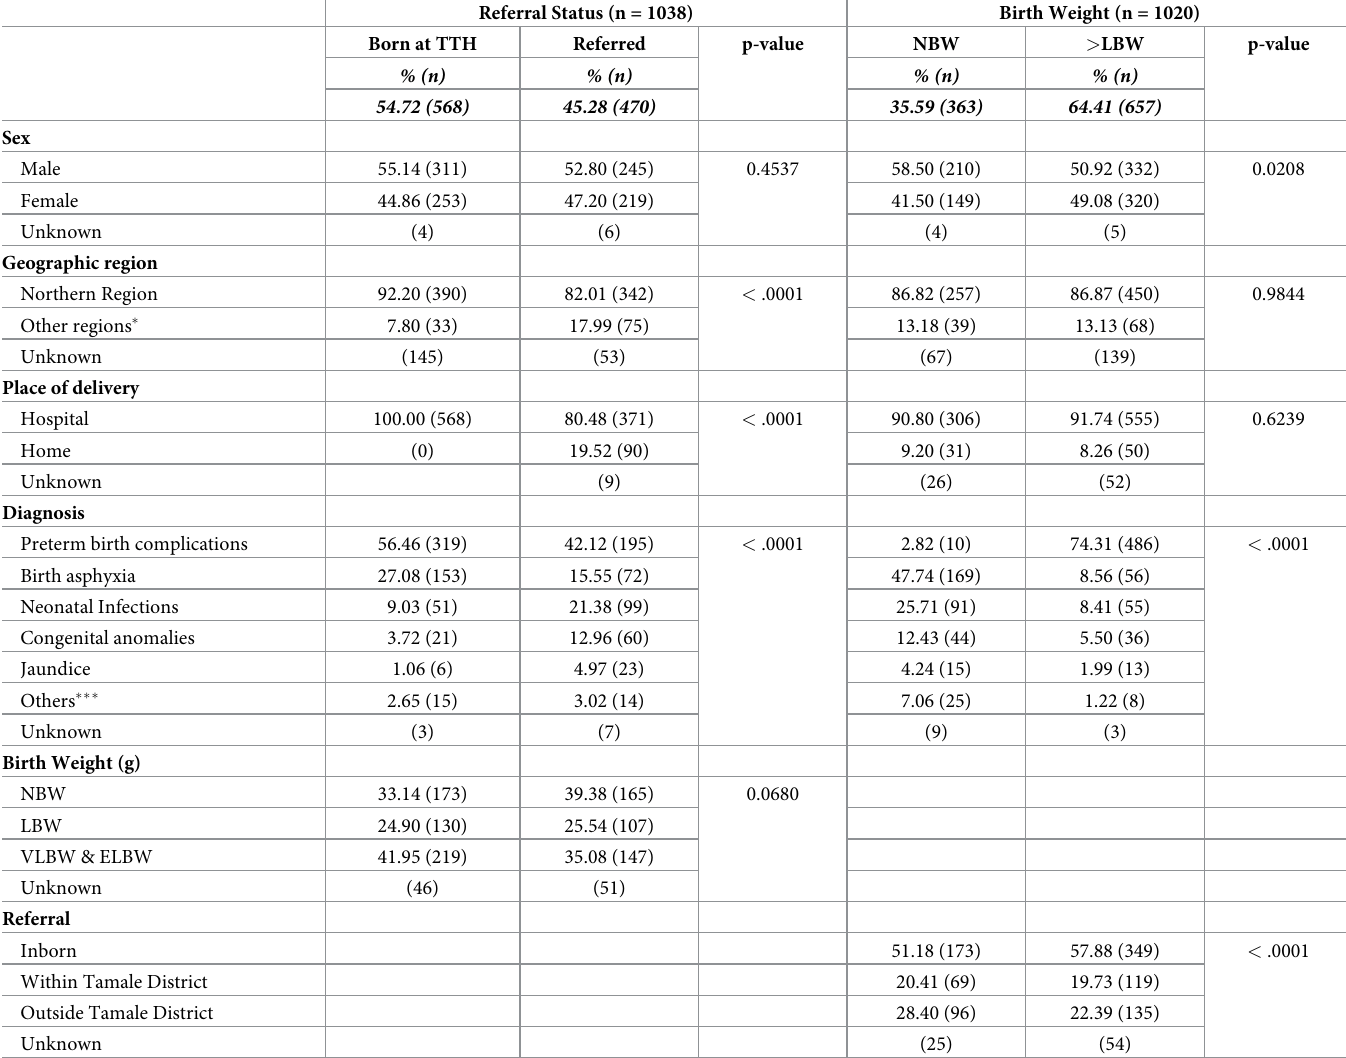
Table 2. Demographic characteristics of neonatal deaths in NICU at Tamale Teaching Hospital, stratified by referral status and birth weight. Referral Status (n =